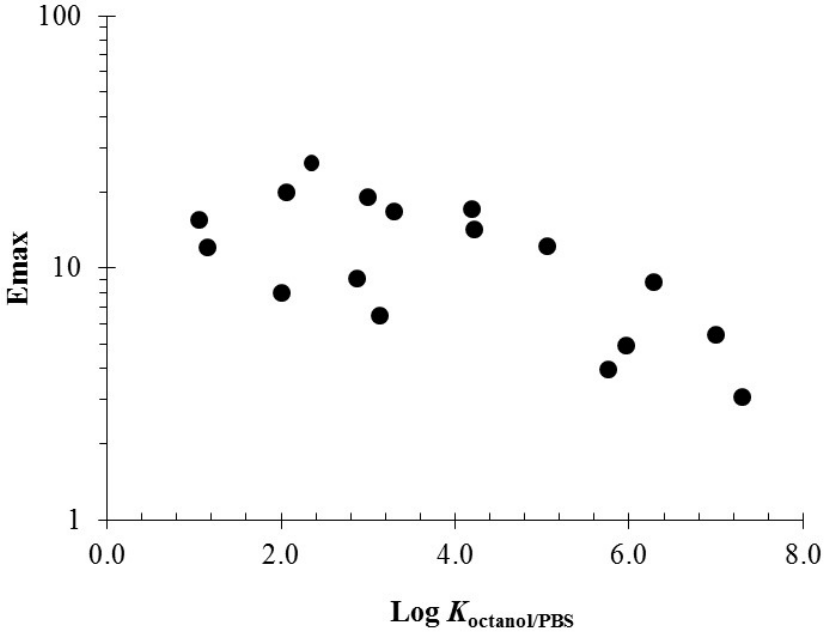
Figure 8. Relationship between maximum enhancement effects (Emax) and Log K of the enhancers. The data are taken from previous human epidermal membrane (HEM) studies